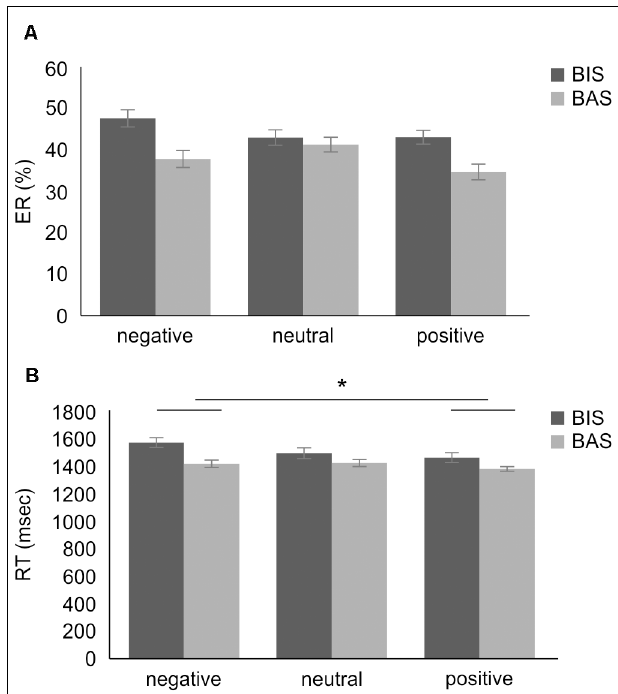
FIGURE 4 | The results of the two-way mixed-design ANOVA for dual 2-back task performance. (A) The results of the two-way mixed-design ANOVA of ER. There was no significant main effect and interaction. (B) The results of the two-way mixed-design ANOVA of the RT. There was a significant main effect of emotional valence, but no interaction. The post hoc test showed significantly increased RT in the negative compared with the positive valence condition. * p < 0.01. Error bars indicate the standard error. ANOVA, analysis of variance; BIS, behavioral inhibition system; BAS, behavioral activation system; ER, error rate; RT, reaction